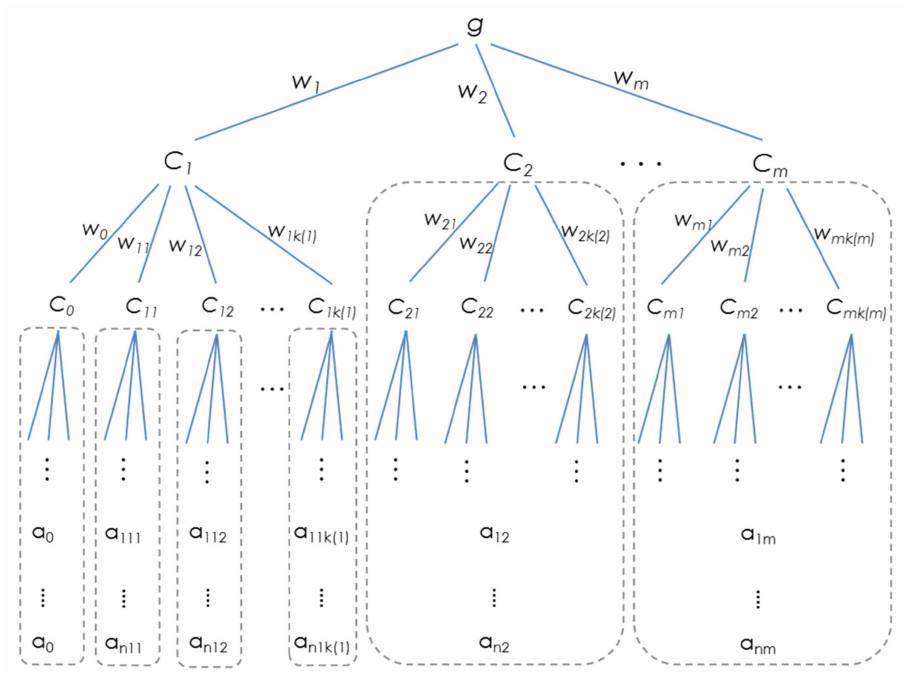
Figure 1. Deep SAW